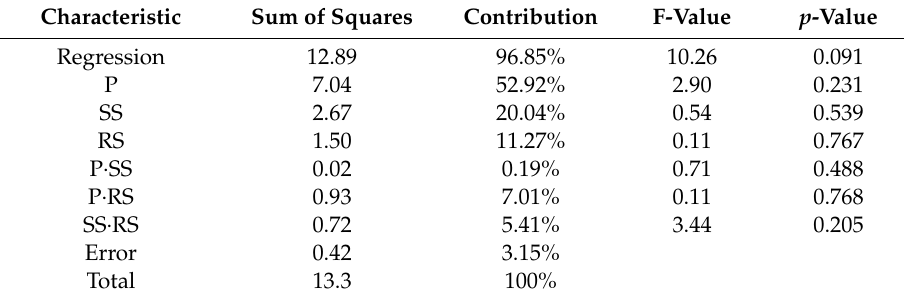
Table 6. ANOVA analysis for the tooth top hardened